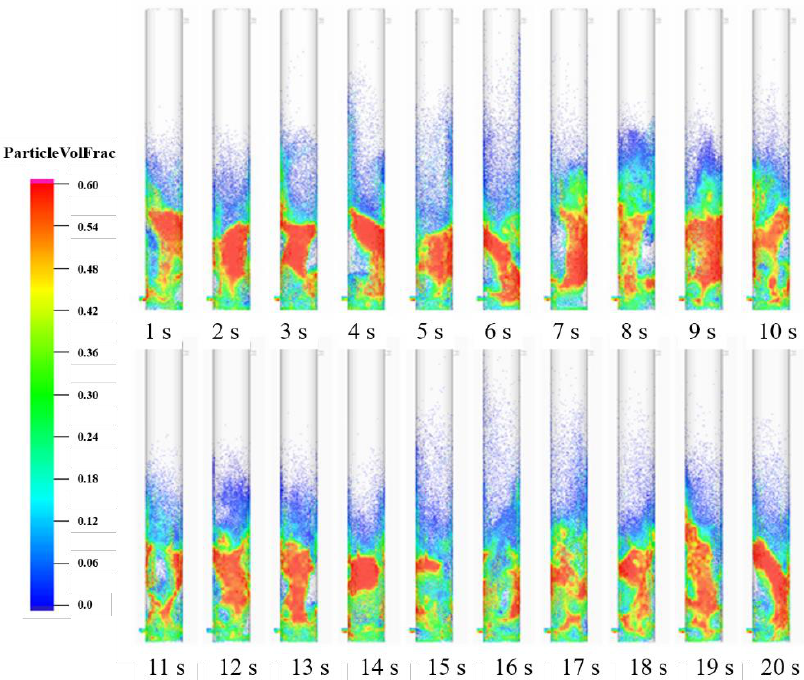
Figure 4. The gas–solid flow field in gasifier based on MP-PIC (ER Figure 4. The gas – solid flow field in gasifier based on MP-PIC (ER 0.2).